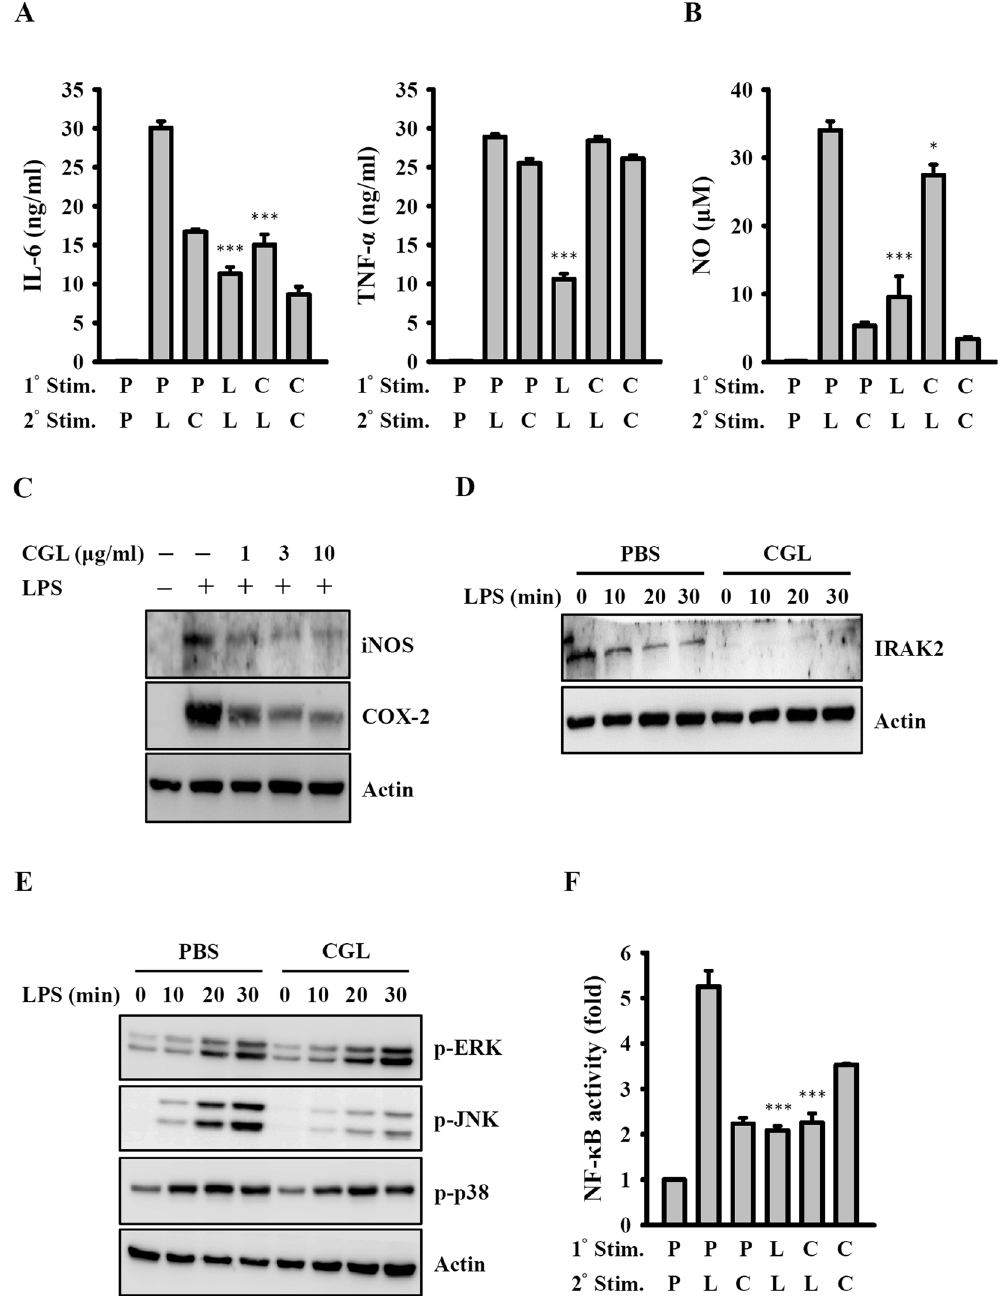
Figure 7. CGL induced endotoxin tolerance. ( A and B ) RAW264.7 macrophages were incubated for 24 h with or without CGL (10 µ g/ml) or LPS (0.1 µ g/ml). After washing, fresh medium was added to the cell cultures followed by a second incubation for 24 h with or without CGL (10 µ g/ml) or LPS (1 µ g/ml). The levels of IL-6 and TNF- α in the culture medium were measured by ELISA ( A ), the levels of NO in the culture medium were measured by Griess reaction ( B ), and the levels of iNOS and COX-2 in the cell lysates were measured by Western blot ( C ). ( D and E ) RAW264.7 macrophages were incubated for 24 h with or without CGL (10 µ g/ml) and subsequently for 0–30 min with or without LPS (1 µ g/ml). IRAK2 expression ( D ), and phosphorylation levels of ERK1/2, JNK1/2 and p38 ( E ) were assayed by Western blot. ( F ) RAW-Blue TM cells were incubated for 24 h with or without CGL (10 µ g/ml) or LPS (0.1 µ g/ml). After washing, fresh medium was added to the cell cultures followed by a second incubation for 24 h with or without CGL (10 µ g/ml) or LPS (1 µ g/ml). The activation levels of NF- κ B were measured by NF- κ B reporter assay. Western blot results are representative of those obtained in three different experiments. Data for the other assays are expressed as the mean ± SD of three separate experiments. * and *** indicate significant differences at the level of p < 0.05 and p < 0.001, respectively, compared to LPS-treated cells. P: PBS; C; CGL; L: LPS. The blots in ( A ), ( D ) and ( E ) were cropped; full-length blots are included in the “Supplementary